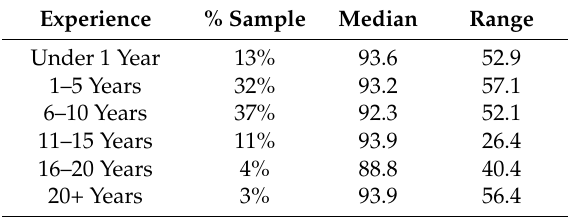
Table 3. Figure 2 plots the distribution of the self-escape confidence variable by level of experience. Table 3. Self-escape confidence across 28 competency items by time at mine ( n =